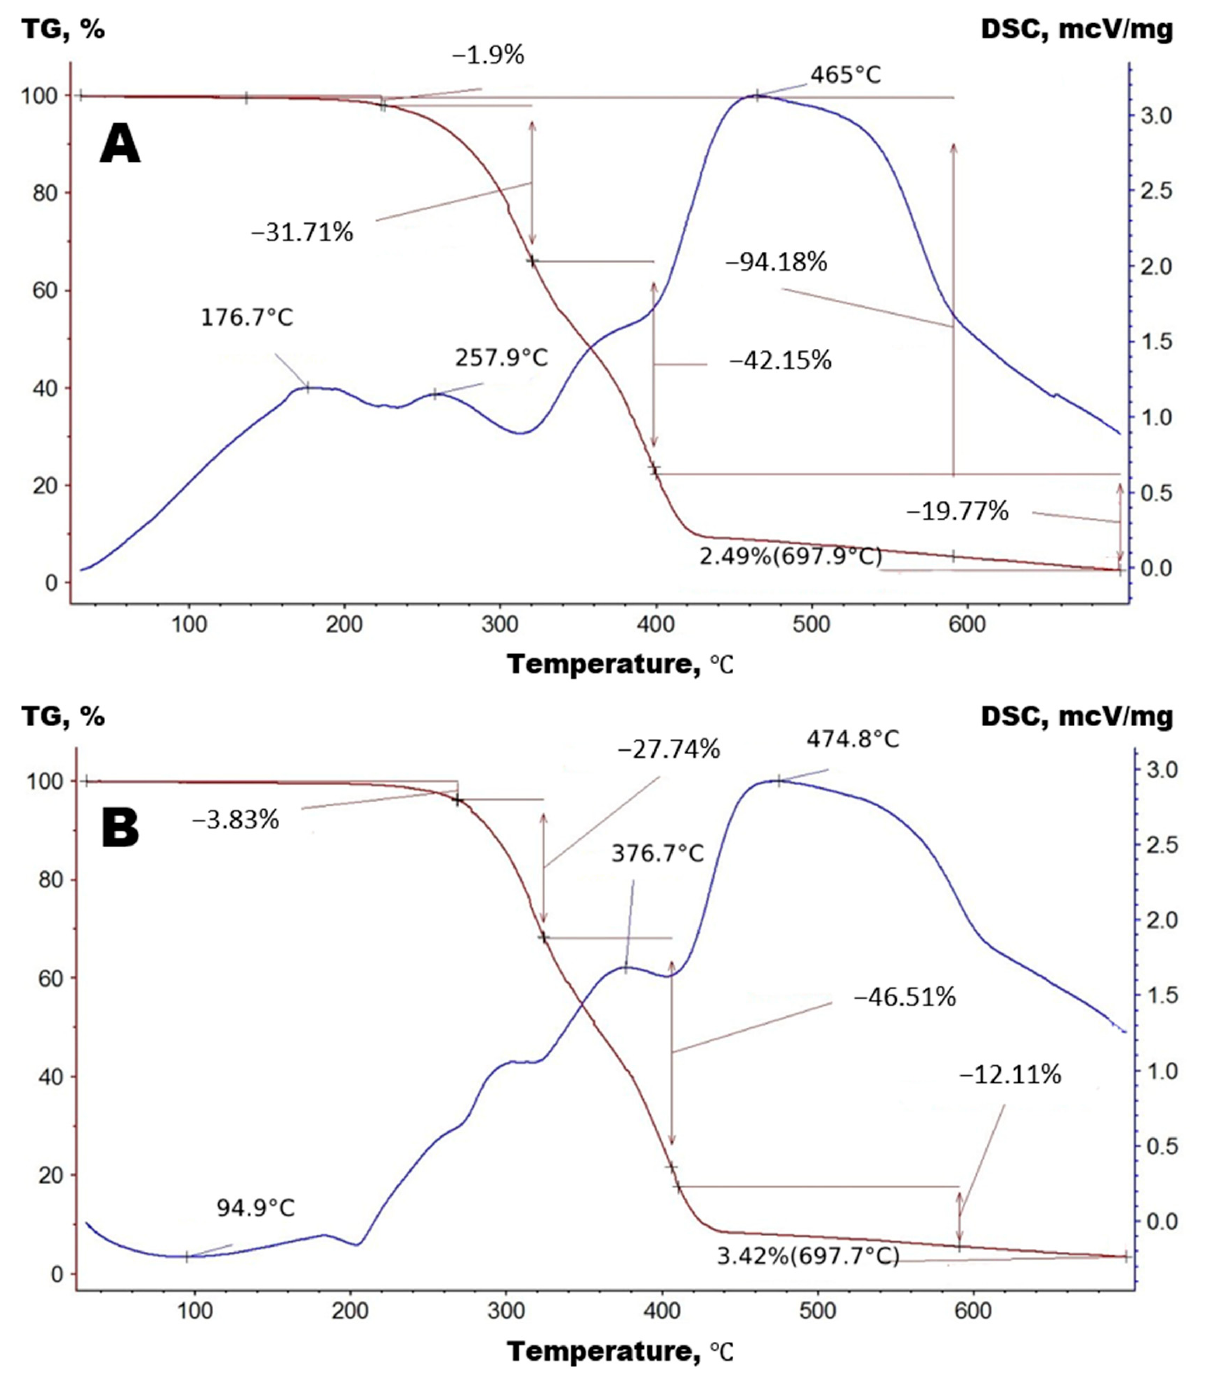
Figure 4. TG and DSC of ( A ) NPU 1; ( B ) NPU 2.